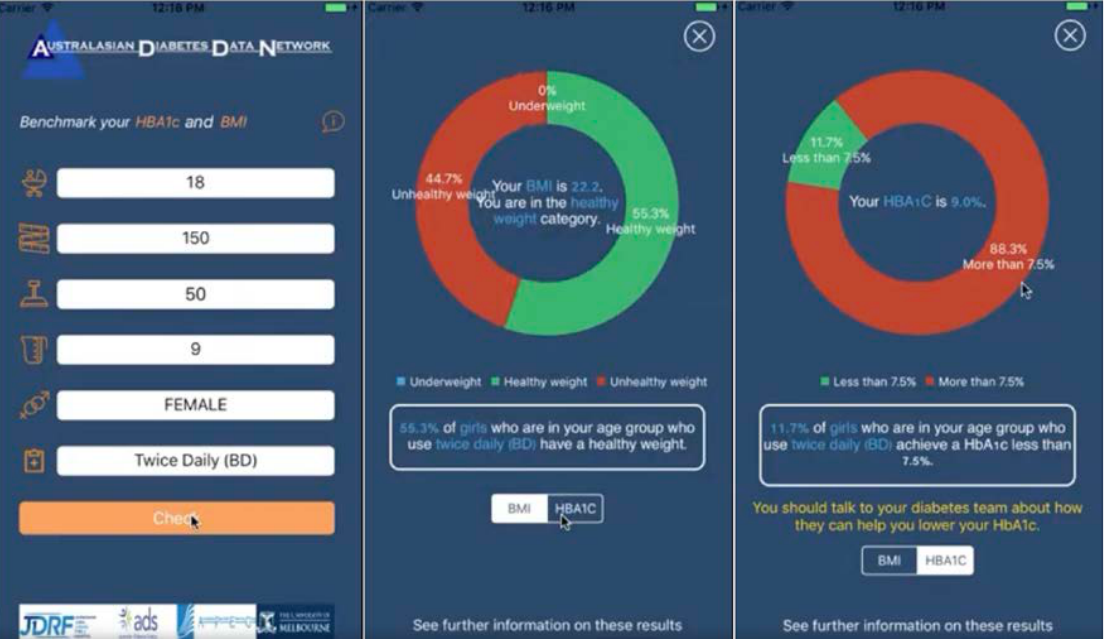
Figure 5. ADDN mobile app for comparison of patient data with registry data.